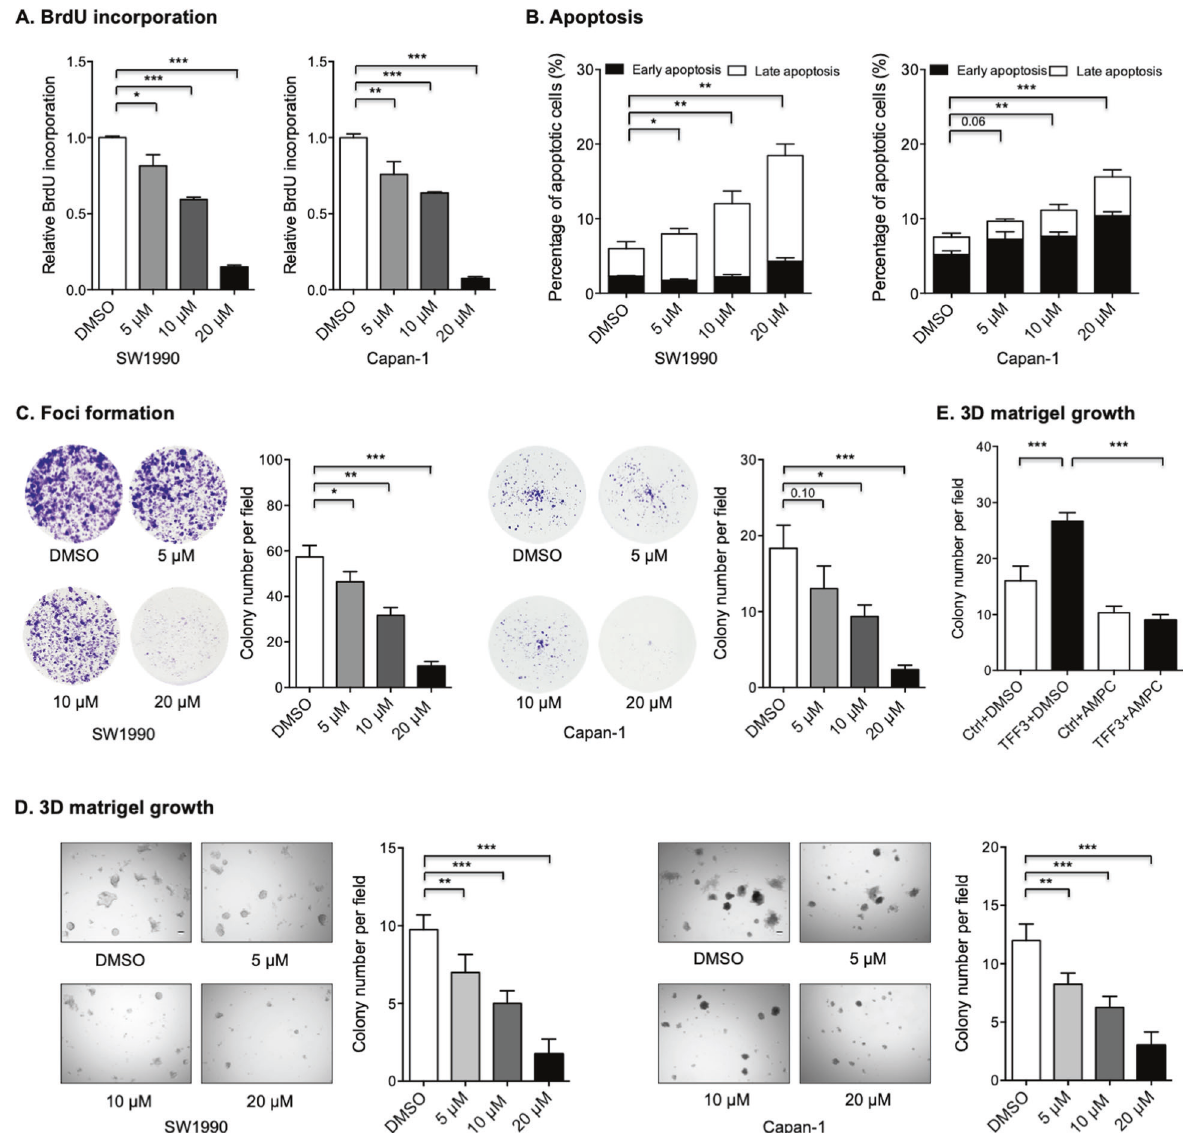
Fig. 4 AMPC suppressed oncogenicity of PDAC cells. A BrdU assay showed that AMPC treatment for 48 hours inhibited the proliferative capability of SW1990 and Capan-1 cells in a dose-dependent manner. B Apoptosis after AMPC treatment for 48 hours was determined using AnnexinV/PI staining followed by FACS analysis. The percentages of cells in the early or late apoptotic phase are plotted. C Foci formation assay showed that AMPC treatment for attenuated foci formation of SW1990 and Capan-1 cells in a dose-dependent manner. D 3D-matrigel growth analysis showed that AMPC treatment attenuated 3D growth of SW1990 and Capan-1 cells in a dose-dependent manner; E 3D-matrigel growth analysis showed that AMPC treatment abrogated the increased 3D growth produced by forced expression of TFF3 in Capan-1